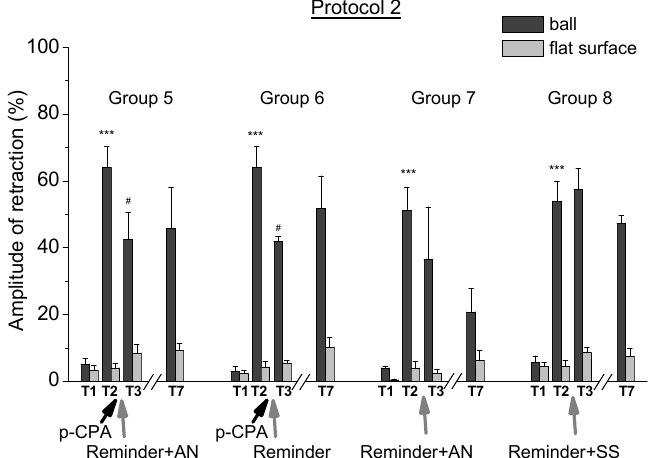
Figure 3. The level of the defensive response (the amplitude of response of ommatophores withdrawal) of snails in two contexts, on the ball and flat surface for the experimental series 2 (protocol 2; Groups 5, 6, 7 and 8). T1—initial testing before the beginning of training, T2—testing 2 days (after 1 day of rest) after elaboration of conditioned reflex (learning), T3–T7—testing of animals after the injections of PCPA, AN and a reminder on the 4th–8th day after a reminder (see Figure 1). Arrows